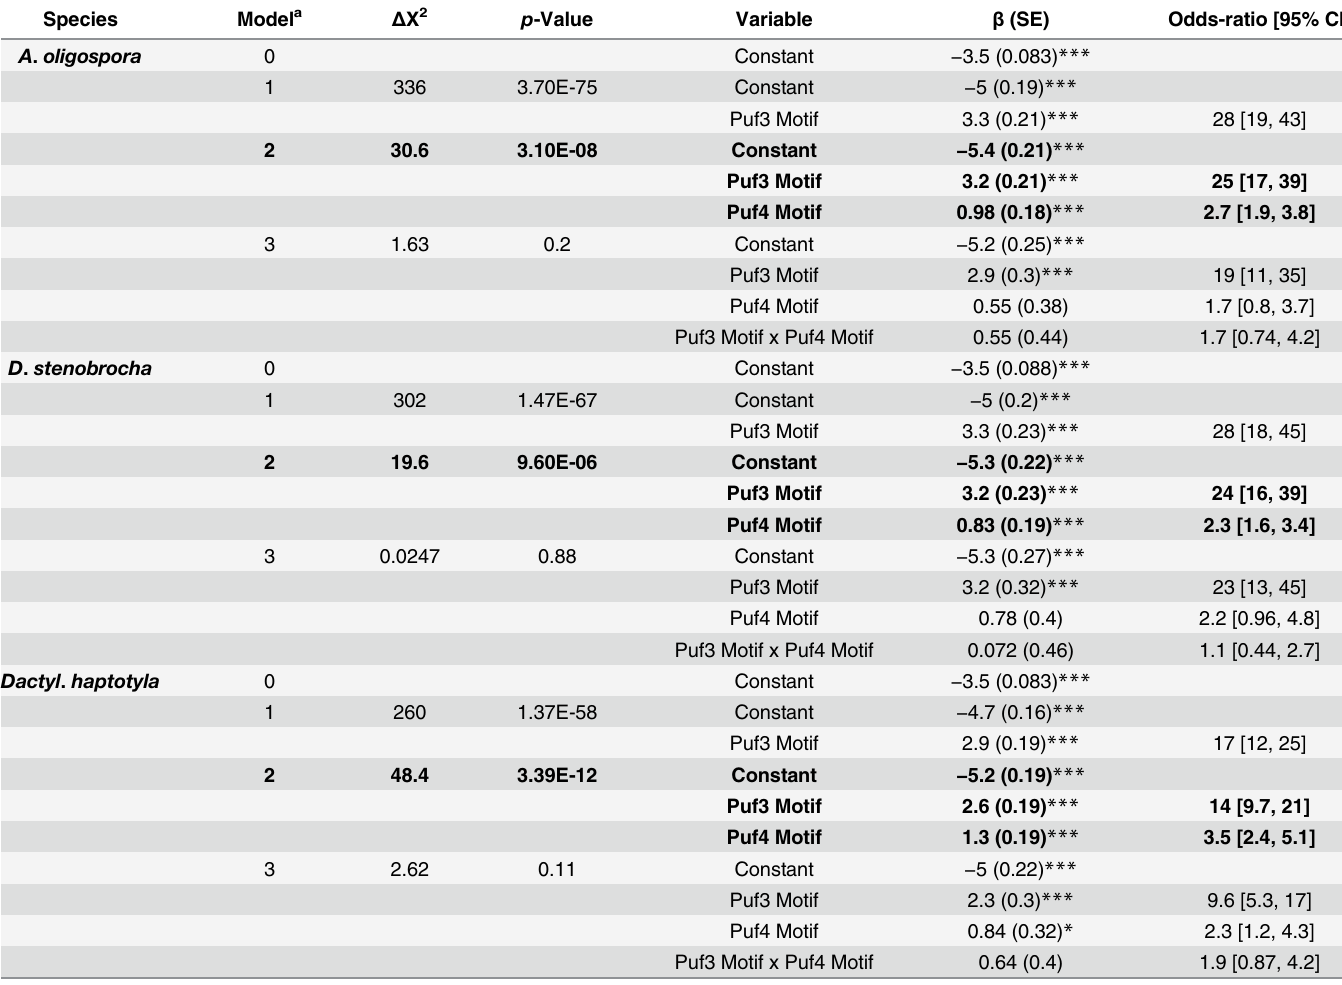
Table 1. Summary of stepwise logistic regression tests for dependence between Puf3 and Puf4 in Orbiliomycetes.